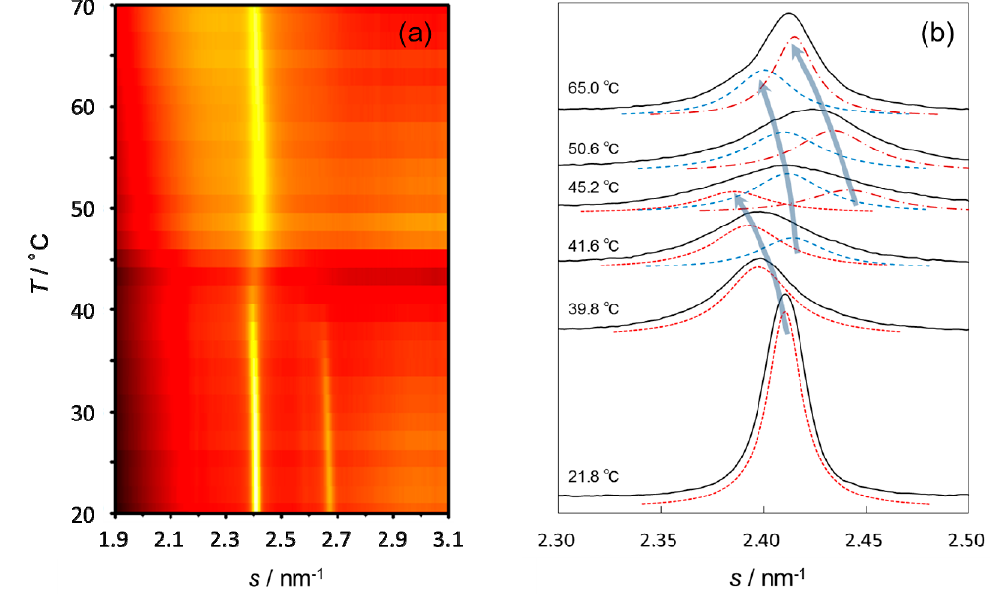
Figure 4. Thermal behavior of the wide-angle X-ray diffraction (WAXD) profiles of human SC in heating from 21.8 °C to 70 °C. ( a ) The temperature dependence of the intensity profile is shown in a colored map (in the order of black < dark red < red < yellow). The scanning rate of temperature was 0.6 K/min, and the data was acquired every 180 s. Two sharp peaks at ~2.4 nm − 1 (P 2.4 ) and ~2.7 nm − 1 (P 2.7 ) are clearly seen in low temperatures. ( b ) Deconvolution of the peak P 2.4 . The intensity profile (solid line) was fitted to Lorentzian function(s) by the simplex method so that every deconvoluted peak (dotted line) shows thermal expansion. Arrows are drawn to guide the eye.